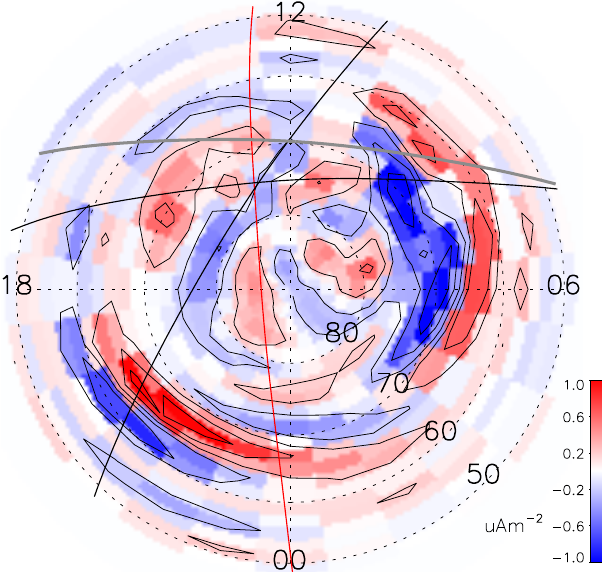
Fig. 6. Birkeland currents, J derived from the data in Fig. 4 k according to Eq. (12) for 03:30–04:30 UT, 1 November, 2001. The DMSP and Oersted tracks are reproduced while the thicker, grey solid line from 06:00 to 18:00 MLT indicates the sunlight terminator boundary in the